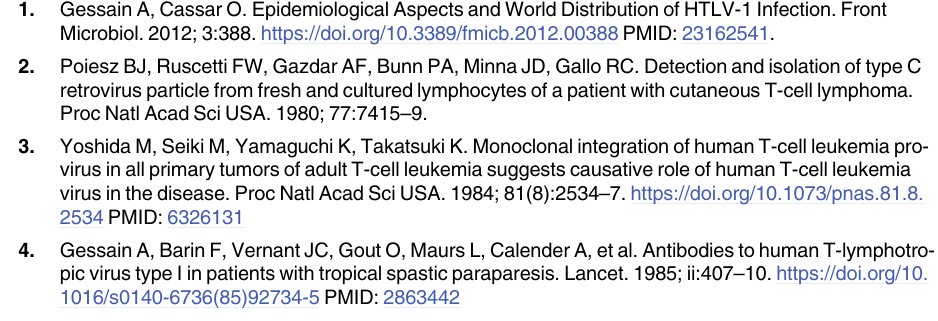
S7 Fig. Inhibition of lysosomal proteases partially restores intracellular levels of SU (gp46) in HTLV-1 infected cells treated with WJ460. ATL-2 cells were treated with DMSO or 1 μ M WJ460 with or without 5 mg/mL leupeptin (L) and 5mg/ml pepstatin A (P) or 25 μ M E64D (E) for 24 h. Whole cell extracts (50 μ g) were analyzed by Western blot using antibodies against β -actin and